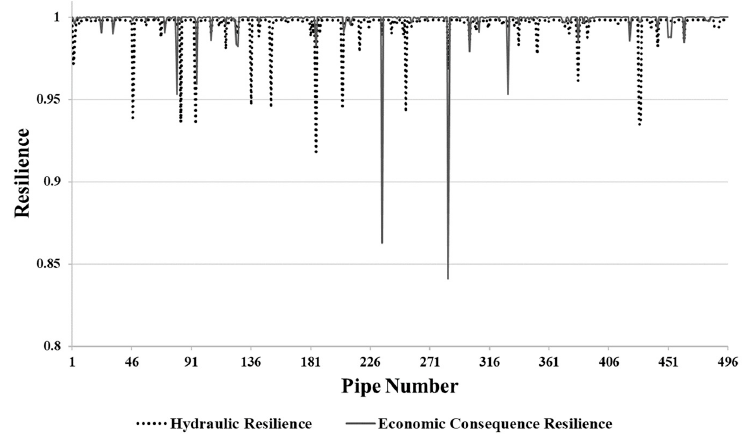
Figure 5. Hydraulic and ECLIPS resilience variation under pipe breakage simulation without pipe replacement.